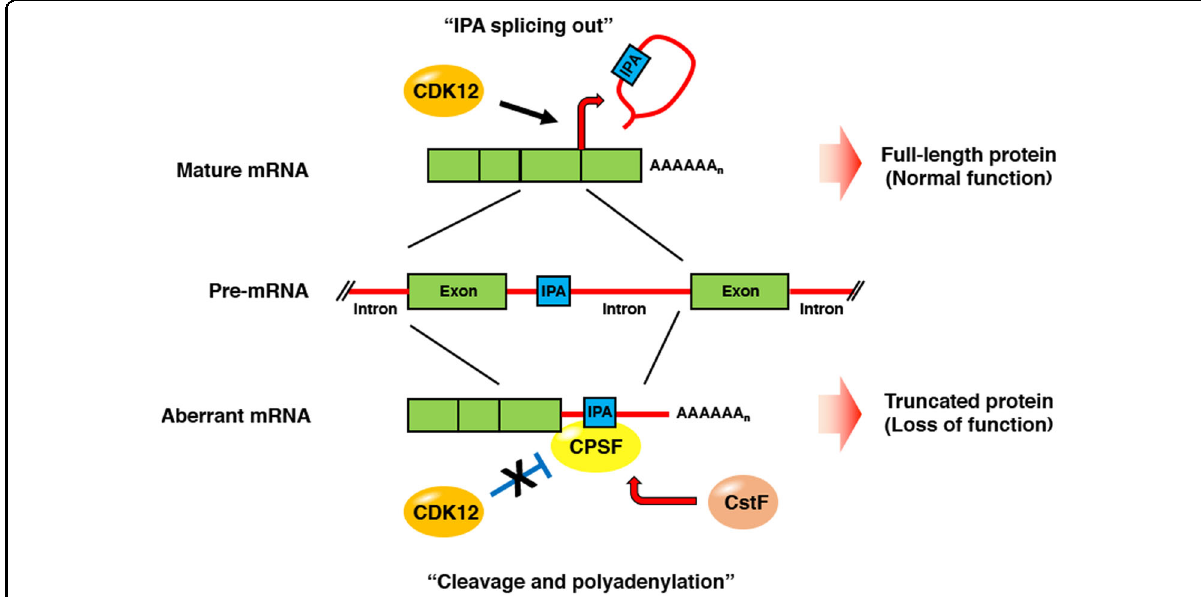
Fig. 2 A model for CDK12 control in the maturation of mRNAs harboring intronic polyadenylation (IPA) sequences. CDK12 facilitates splicing of introns that contain IPA (blue box) and suppresses transcription to generate truncated isoforms of mRNA. Upon losing its function by mutation, CDK12 activity is decreased or delayed, and the remaining IPA-containing intron is not spliced. This event increases “ cleavage and polyadenylation ” by recruiting CPSFs (a cleavage and polyadenylation speci fi city factor, shown as a yellow circle) and CstFs (cleavage stimulating factors, shown as orange circles) to IPA, resulting in an increase in truncated